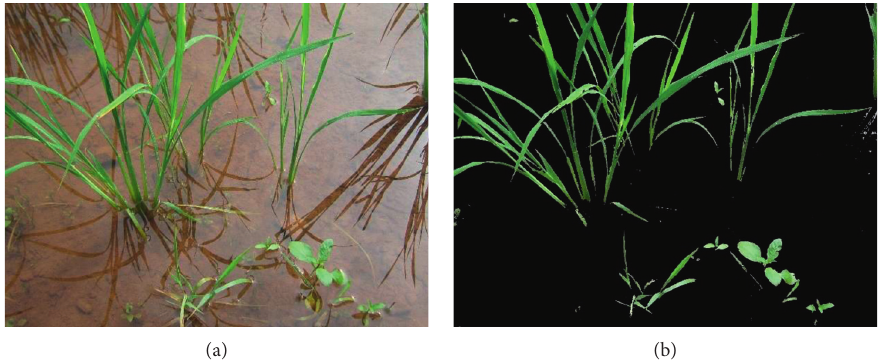
Figure 2: (a) Image taken at a distance of 0.16m from the ground using the Canon camera and (b) the corresponding background subtracted image.